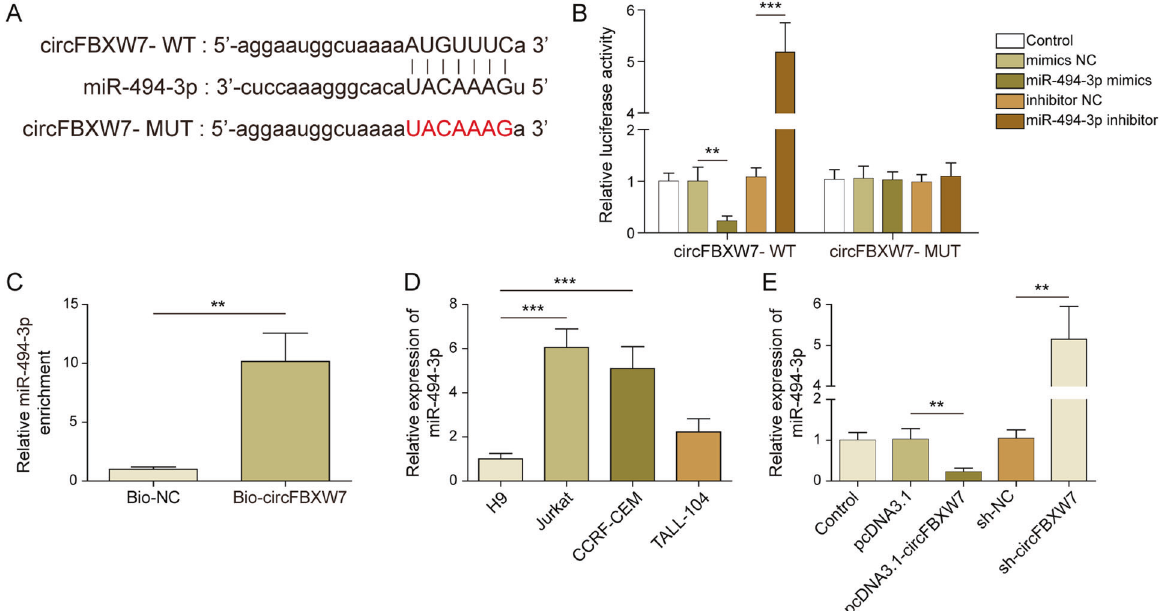
Fig. 2 CircFBXW7 acted as a sponge of miR-494-3p. A Bioinformatic prediction showed that circFBXW7 had putative binding sites with miR- 494-3p. B Dual-luciferase reporter assay indicated that circFBXW7 bound with miR-494-3p. C RNA pull-down suggested that miR-494-3p was enriched by ciircFBXW7. D RT-qPCR investigation showed that miR-494-3p was notably upregulated in T-ALL cells. E RT-qPCR detection revealed that miR-494-3p level was negatively regulated by circFBXW7. The quantitative values are expressed as a mean ± SD from three independent experiments. ** P < 0.01, *** P < 0.001.